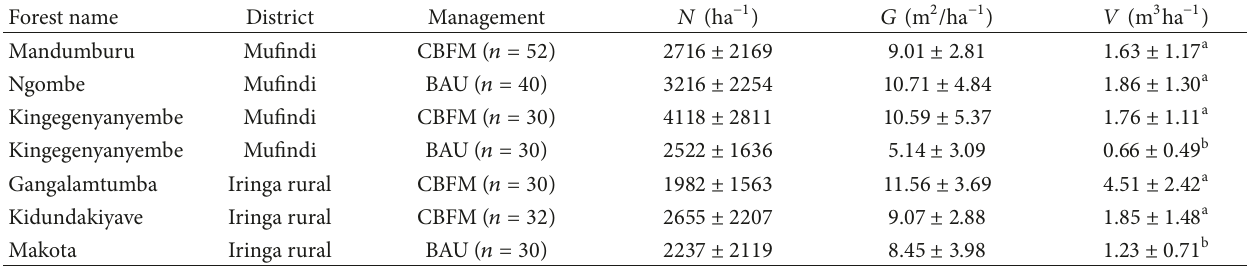
Table 3: Stocking parameters in miombo woodlands based on management practices.